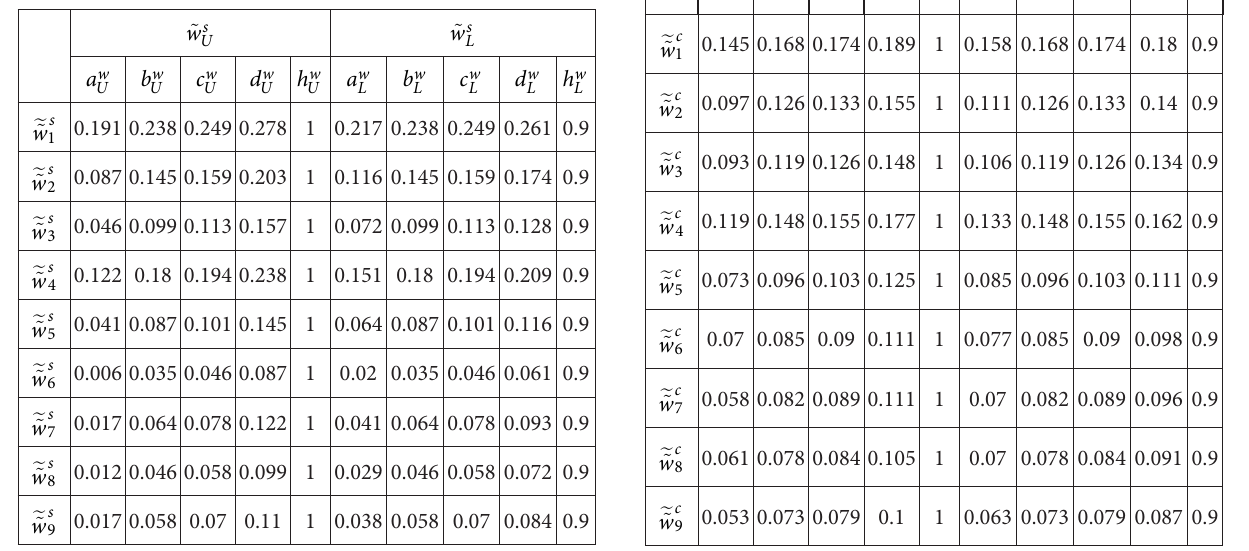
Table 4. The average subjective criteria